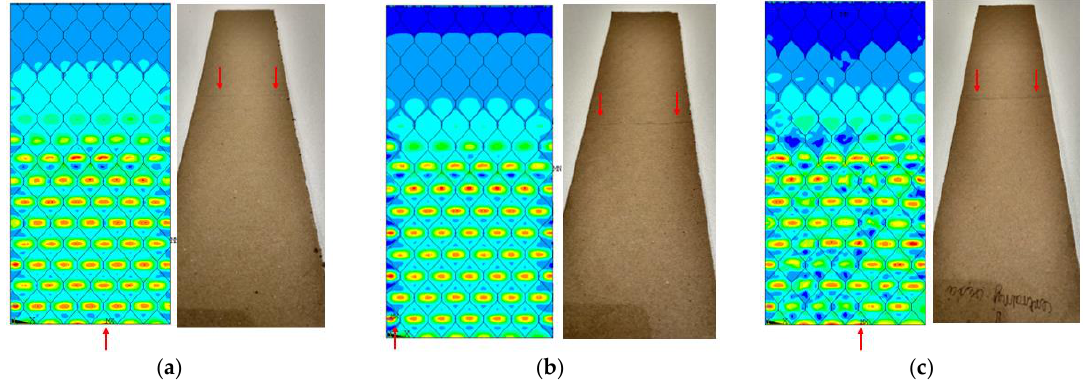
Figure 17. Comparison of failure places in CD direction: ( a ) H = 8 mm ( b ) H = 18 mm ( c ) H = 28 mm.